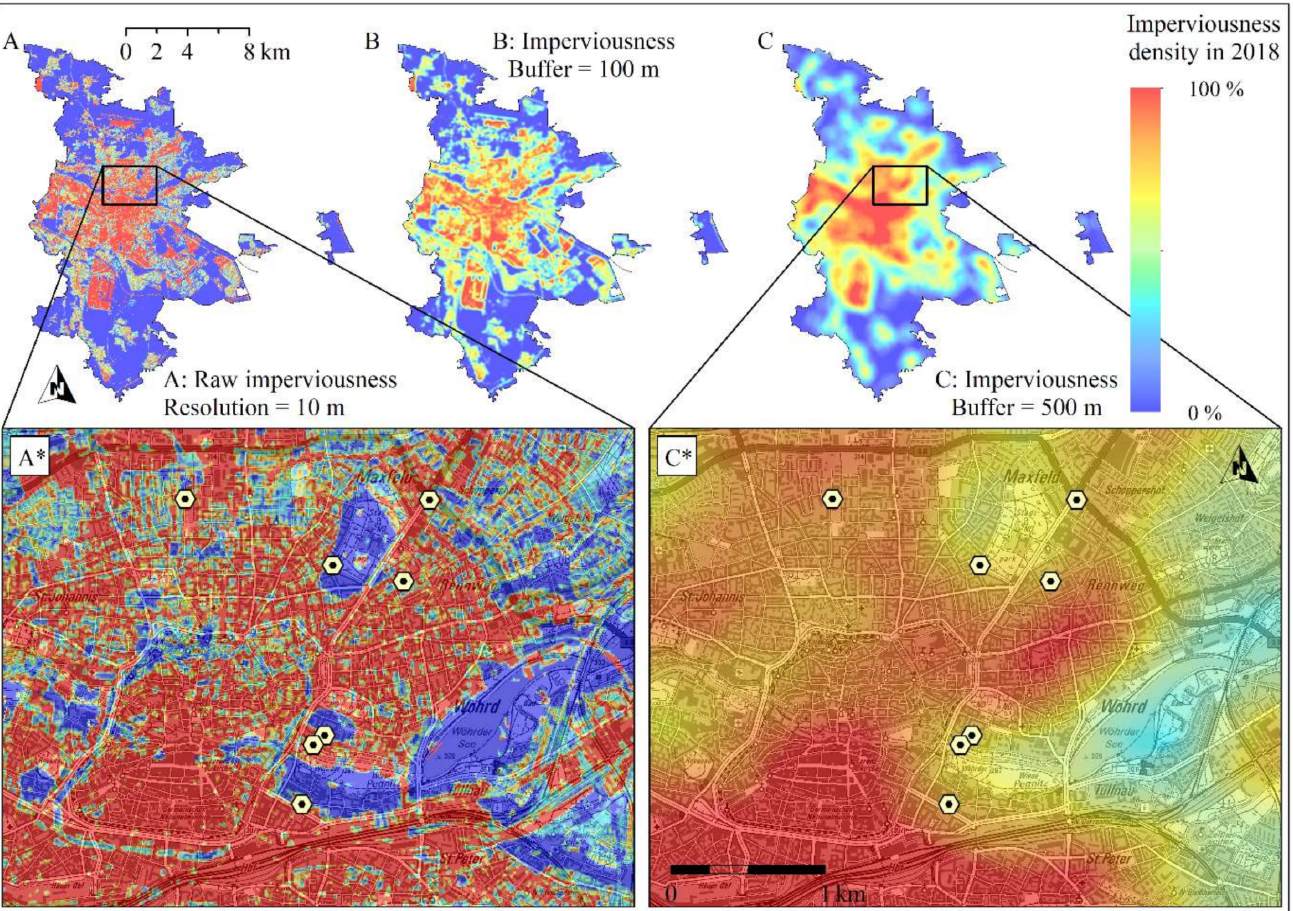
Figure 2. Recalculation of the original IMD grid ( A , A *) to IMD r = 100 ( B ) and IMD r = 500 ( C , C *). For IMD orig ( A , A *), sealing values of 0% or 100% were extracted for a large number of observation wells. A dependency between sealing density and the annual temperature shift could, therefore, not be determined. In contrast, in ( C *), with a circular buffer of 500 m, it was possible to derive different urban settings and to work out a statistical correlation between the individual